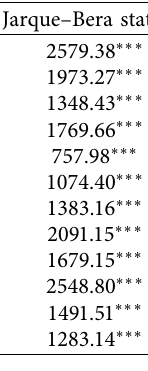
Table 2: Statistical characteristics of the 12 regional